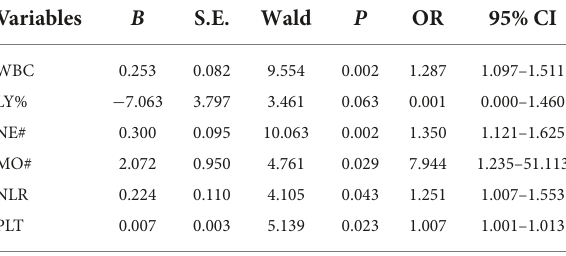
TABLE 3 Predictors of fetal ventriculomegaly (VM) in univariable logistic regression model.